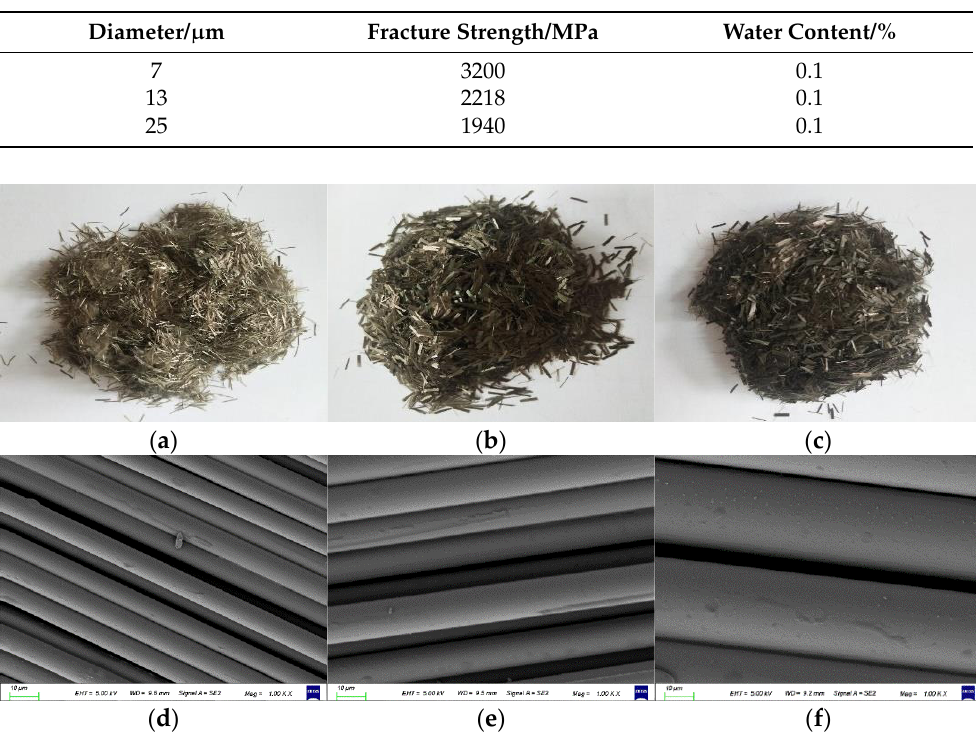
Table 1. Properties of SBS modified asphalt.